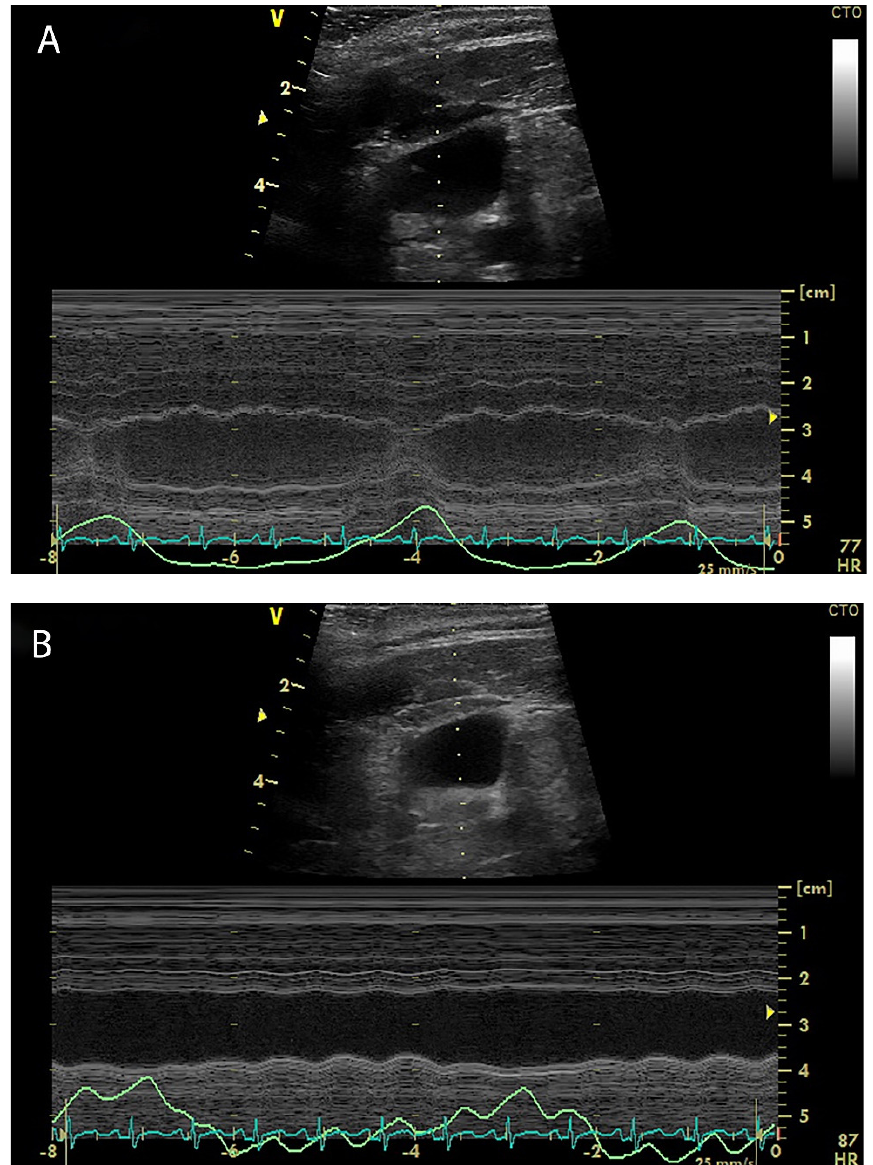
Figure 2. M-mode view of the antero-posterior diameter of the internal jugular vein shows differences in variability in a fluid responsive ( A ) and non-responsive ( B ) mechanically ventilated patient.